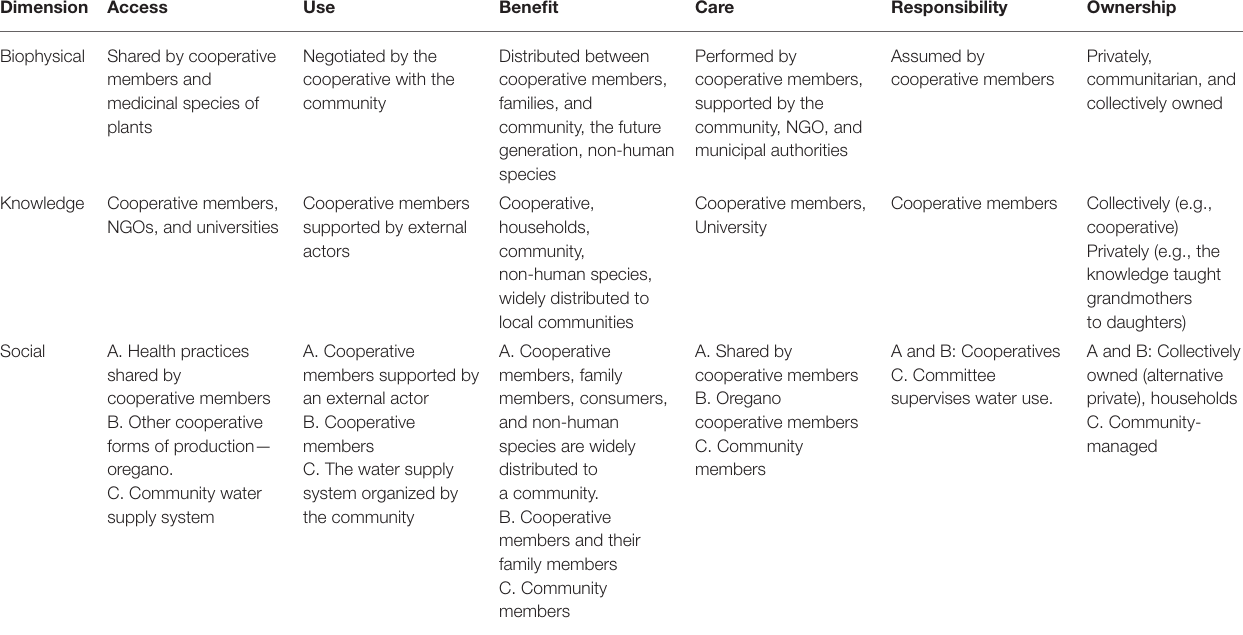
TABLE 3 | Forms of commons performed by Manzanas. Dimension